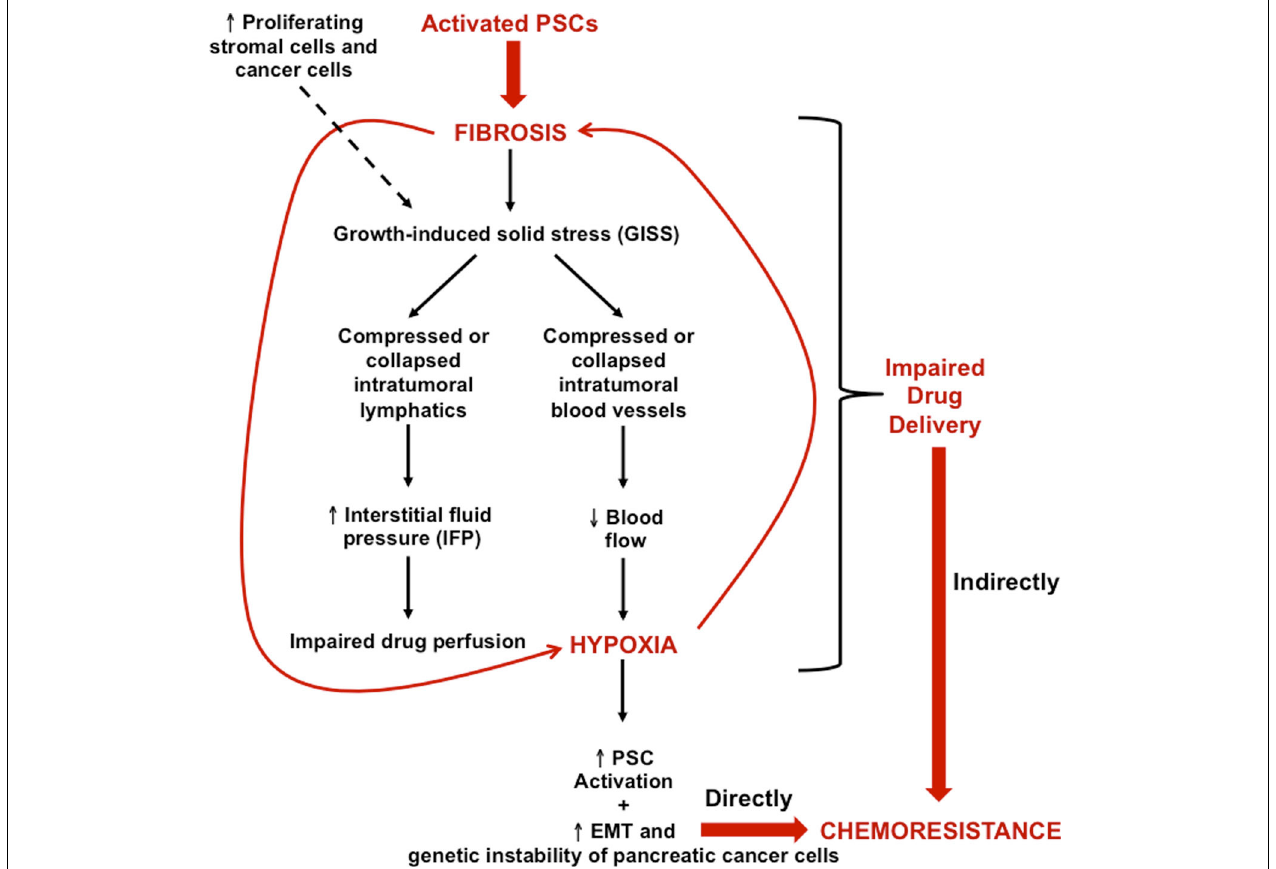
FIGURE 2 | Growth-induced solid stress (GISS), the hypoxia-fibrosis cycle and their contribution to chemoresistance. Continuous PSC activation results in excessive ECM deposition, particularly of tensile-resistant fibrillar collagen as well as compression-resistant hyaluronan. This eventually leads to prominent fibrosis which, along with deformation caused by the number of proliferating stromal cells and cancer cells, results in GISS. Consequently, this reduces the caliber of intratumoral lymphatics and blood vessels. The former leads to increased